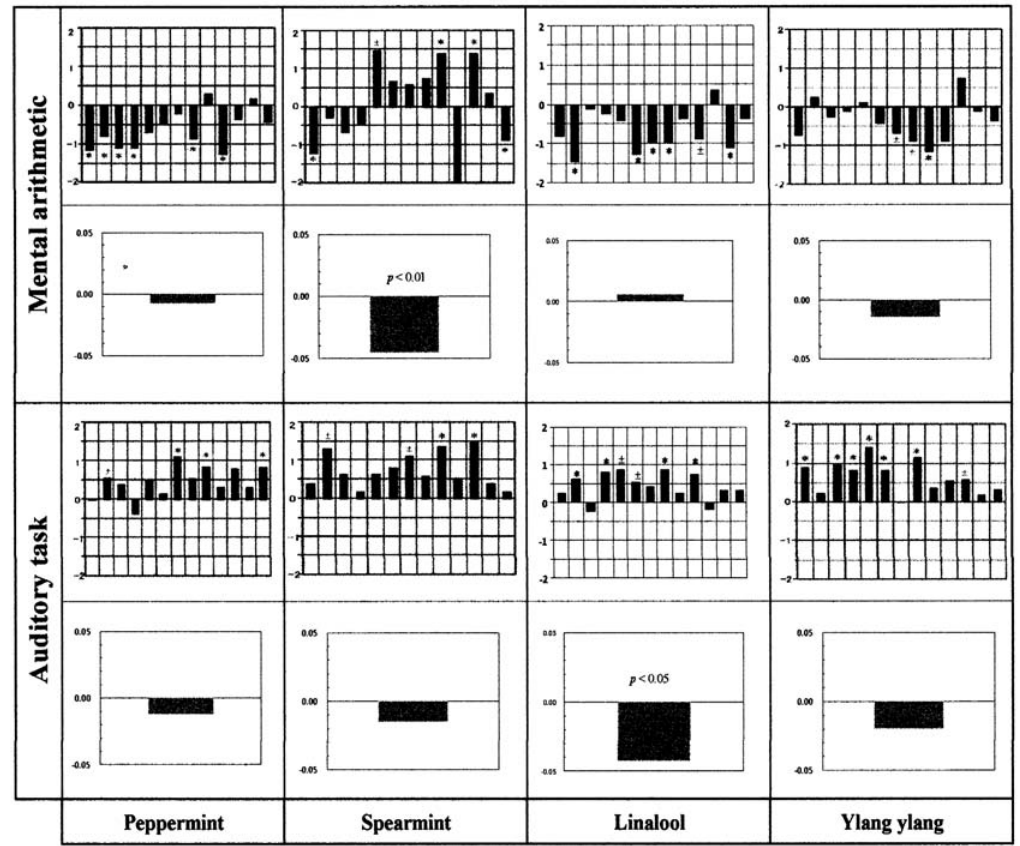
Figure 10. Essential oils showing “harmonization” in terms of the sensory spectra and skin temperature changes as a function of behavioural task. The conception of “harmonization” was introduced by Hongratanaworakit and Buchbauer as for ylang ylang [17]. From the view of this conception, we made attempts to search such an essential oil on the basis of our obtained task-dependent sensory spectra and fingertip skin temperature changes. With the ylang-ylang’s sensory spectra and net intensity fingertip skin temperature changes as a reference, two essential oils (peppermint and spearmint) and one monoterpenoid (linalool) were